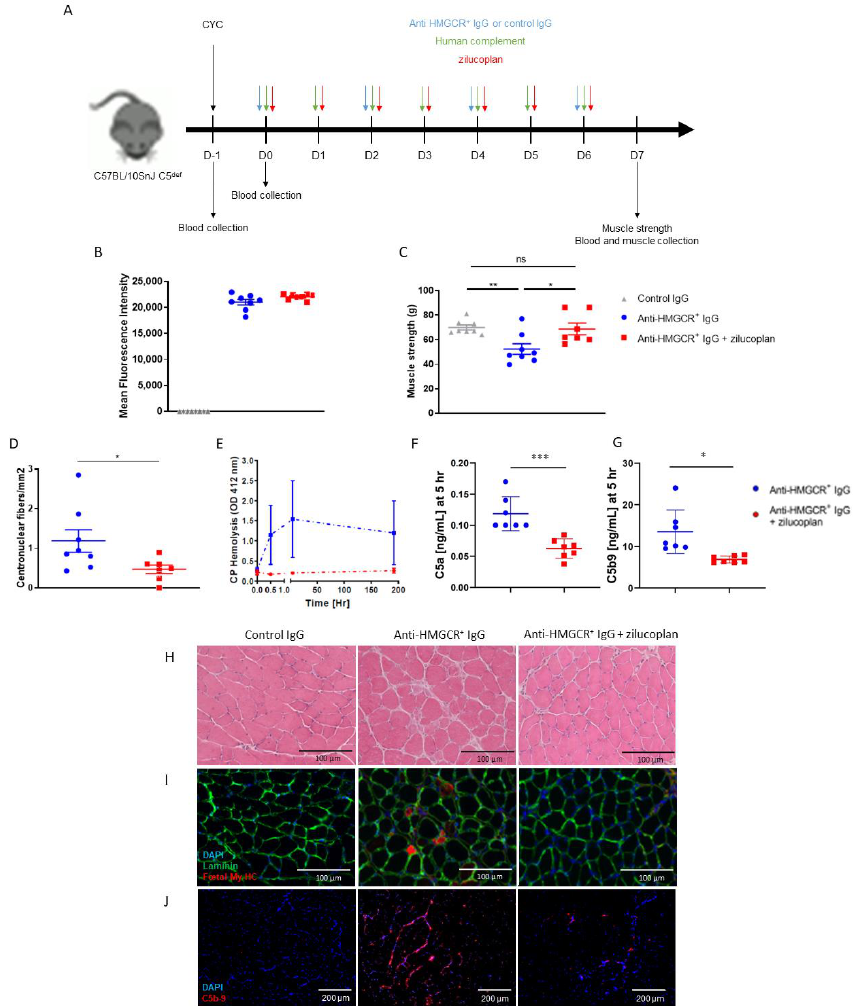
Figure 1. C5 inhibition prevents the development of IMNM in C5-deficient mice supplemented with human complement. ( A ) C57BL/10SnJ C5-deficient (C5 def ) mice (n = 8/group) were transiently im- munosuppressed by a single injection of cyclophosphamide (CYC) and received injections of purified IgG from a patient suffering from anti-HMGCR + IMNM with or without zilucoplan in conjunction with human complement. Control is IgG from normal serum in conjunction with human complement. ( B ) Circulating levels of anti-HMGCR aAb by addressable laser beads immunoassay (ALBIA) in the serum of mice at day 7. ( C ) Muscle strength was evaluated by measurement of gastrocnemius con- traction upon electrostimulation (muscle strength). ( D ) Quantification of regenerative muscle fibres in all assessable frozen tibialis muscle biopsies from mice injected with control IgG or anti-HMGCR + IgG with or without zilucoplan. ( E ) In vitro classical pathway complement-mediated haemolysis assay in serum from mice injected with control IgG or anti-HMGCR + IgG with or without zilucoplan at day 0, 30 min, 5 h and day 7. ( F , G ) Quantification by ELISA of C5a and C5b-9 in serum from mice injected with control IgG or anti-HMGCR + IgG with or without zilucoplan at day 0, 5 h. ( H ) H & E staining. Scale bar = 100 µ m. ( I ) Immunodetection of regenerative myofibres after staining with mouse anti-foetal myosin heavy chain (My-HC) antibody followed by Alexa 647-labeled anti-mouse IgG antibody (red). Muscle fibres are made visible using rabbit anti-laminin antibody followed by Alexa 488-labeled anti-rabbit IgG (green) and DAPI (blue) for staining nuclei. Scale bar = 100 µ m. ( J ) Complement deposits (red) on the surface of myofibres after staining with rabbit anti-C5b-9 antibody followed by Alexa 647-labeled anti-rabbit IgG and DAPI counterstaining (blue). Scale bar = 200 µ m. Data are presented as mean ± SD; ns is for non-significant * p < 0.05, ** p < 0.01, *** p < 0.001 by Mann–Whitney two-tailed test. One out of two reproducible experiments is